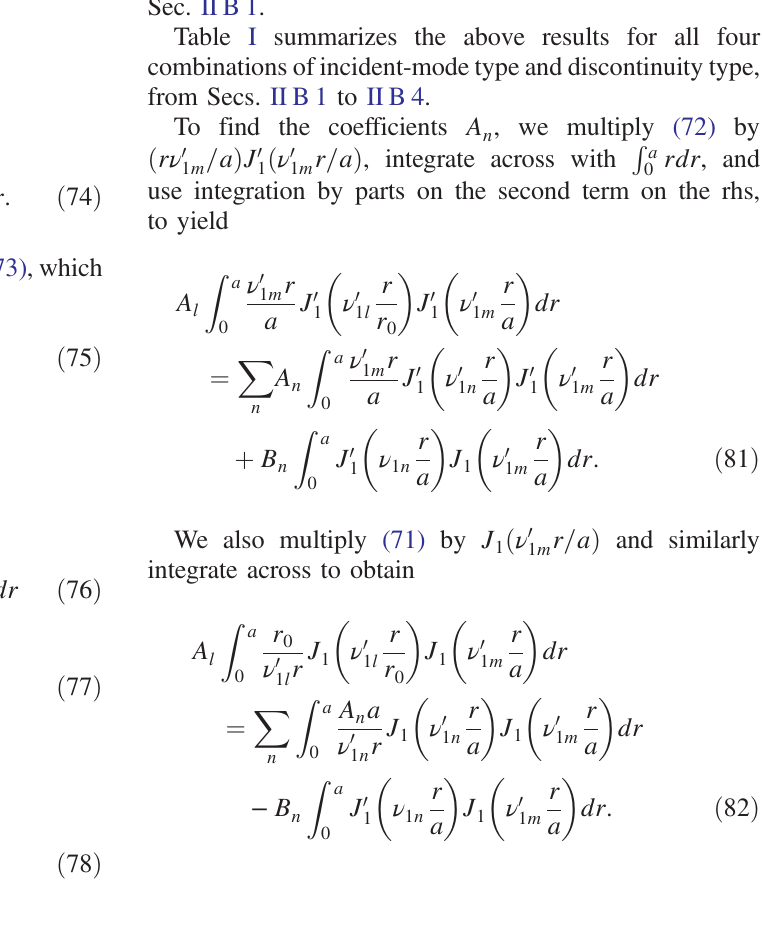
Þ , for a TE/TM mode incident ; B n n